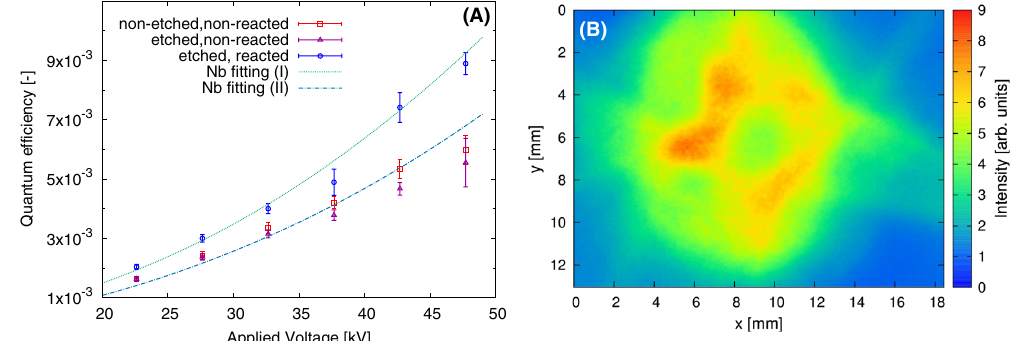
FIG. 8. Experimental results and numerical fit for high charge regime. (a) Quantum efficiency as a function of the applied voltage for nonreacted/nonetched and nonreacted/etched samples. The lines represent the numerical results for Nb using the three-step model. Fit parameters for reacted (I) (cid:9) ¼ 4 : 73 eV , (cid:10) ¼ 150 0 000 m (cid:1) 1 , T ¼ 3000 K and for nonreacted (II) (cid:9) ¼ 4 : 73 eV , (cid:10) ¼ 120 0 000 m (cid:1) 1 , T ¼ 3000 K . (b) Electron beam profile at SCR2, affected by space-charge